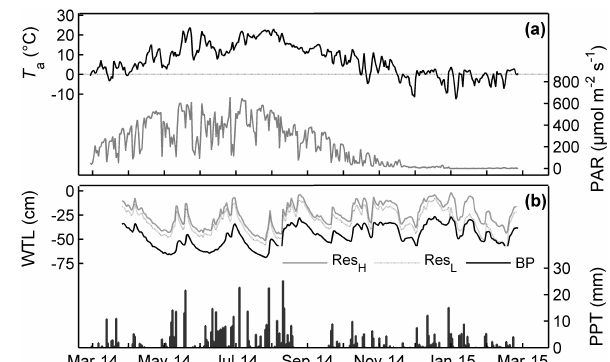
Figure 1. (a) Daily means of air temperature ( T a ) and photosyn- thetically active radiation (PAR) and (b) daily sums of precipitation (PPT) and daily means of water table level (WTL) in restoration treatments with high (Res H ) and low (Res L ) WTL, and bare peat (BP) from March 2014 to February 2015; T a , PAR and PPT data are taken from the Viljandi and Tartu meteorological stations (until 17 June) and measured at the study site (from 18 June onward).